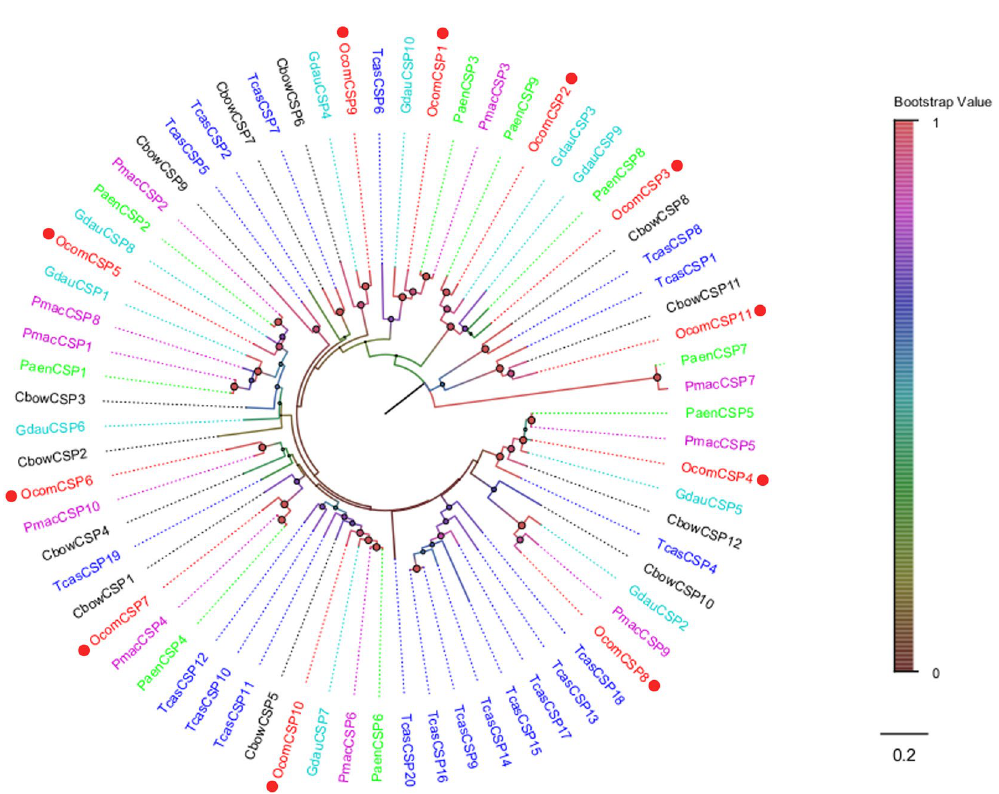
Figure 4. Neighbor joining phylogenetic tree of candidate OcomCSPs with known Coleopteran CSP sequences. Tcas, Tribolium castaneum (N = 19); Pmac, Pyrrhalta maculicollis (N = 10); Paen, Pyrrhalta aenescens (N = 9); Gdua, Galeruca daurica (N = 10); Cbow, Colaphellus bowringi (N = 12). Candidate OcomCSPs were indicated by red